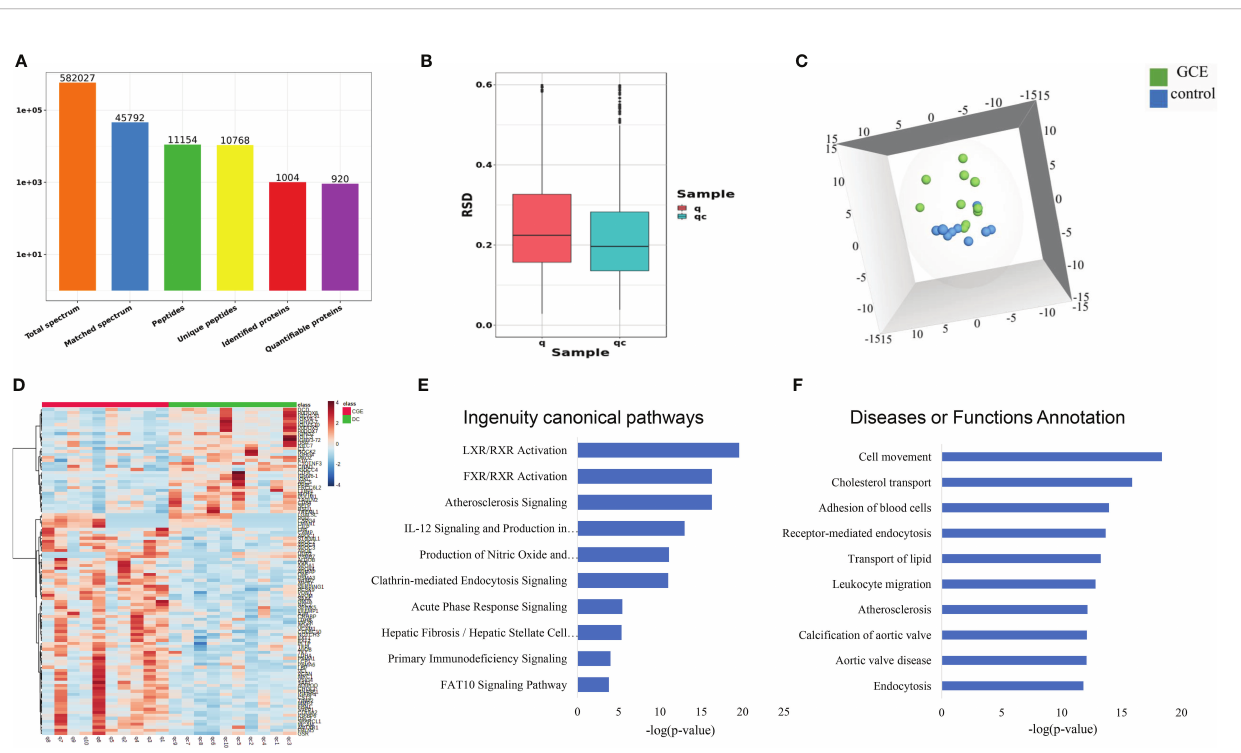
FIGURE 2 | Serum proteomic pro fi ling of CGE patients. (A) Protein and peptide numbers identi fi ed from the serum sample; (B-D) The RSD distribution, PCA analysis, and heat map analysis of samples between CGE and disease control groups; (E, F) IPA analysis of differentially expressed proteins between CGE patients and disease controls.